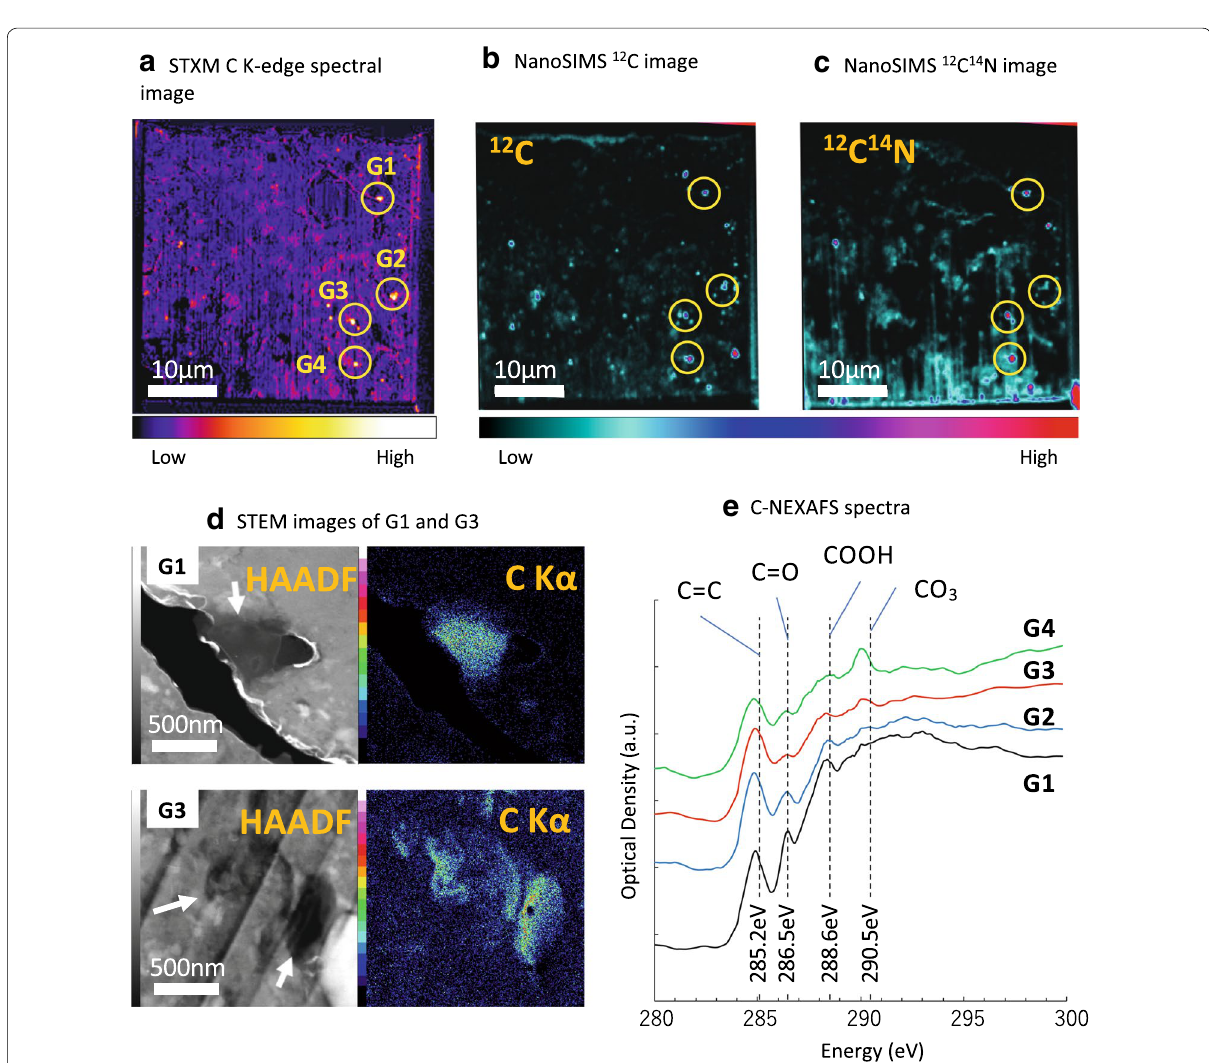
Fig. 6 Images of carbonaceous grains in the FIB section of Y-791198. a Scanning transmission X-ray microscopy (STXM) C K-edge spectral image, b NanoSIMS 12 C image, c NanoSIMS 12 C 14 N image, d high-angle annular dark field (HAADF) and carbon Kα X-ray images of the G1 and G3